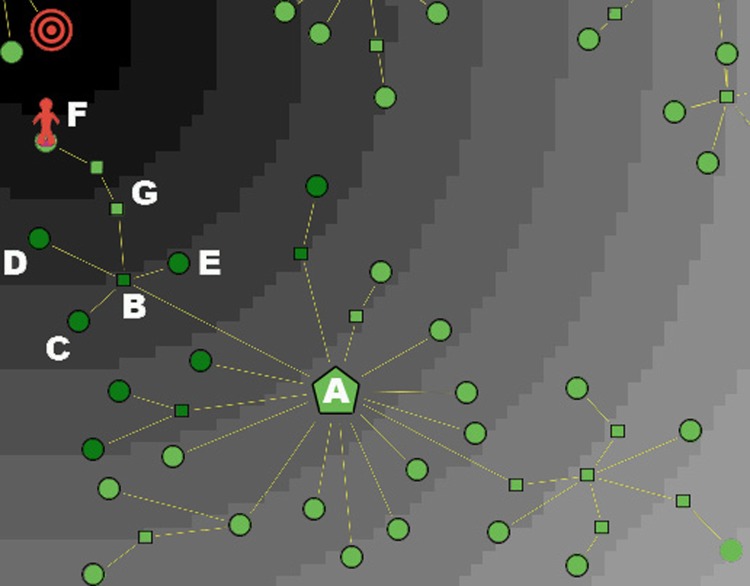
Example of a cul-de-sac.In an attempt to reach her target, the buyer is exploring a branch of her active cluster, but remains trapped in an informative cul-de-sac, and will end her journey on node G.